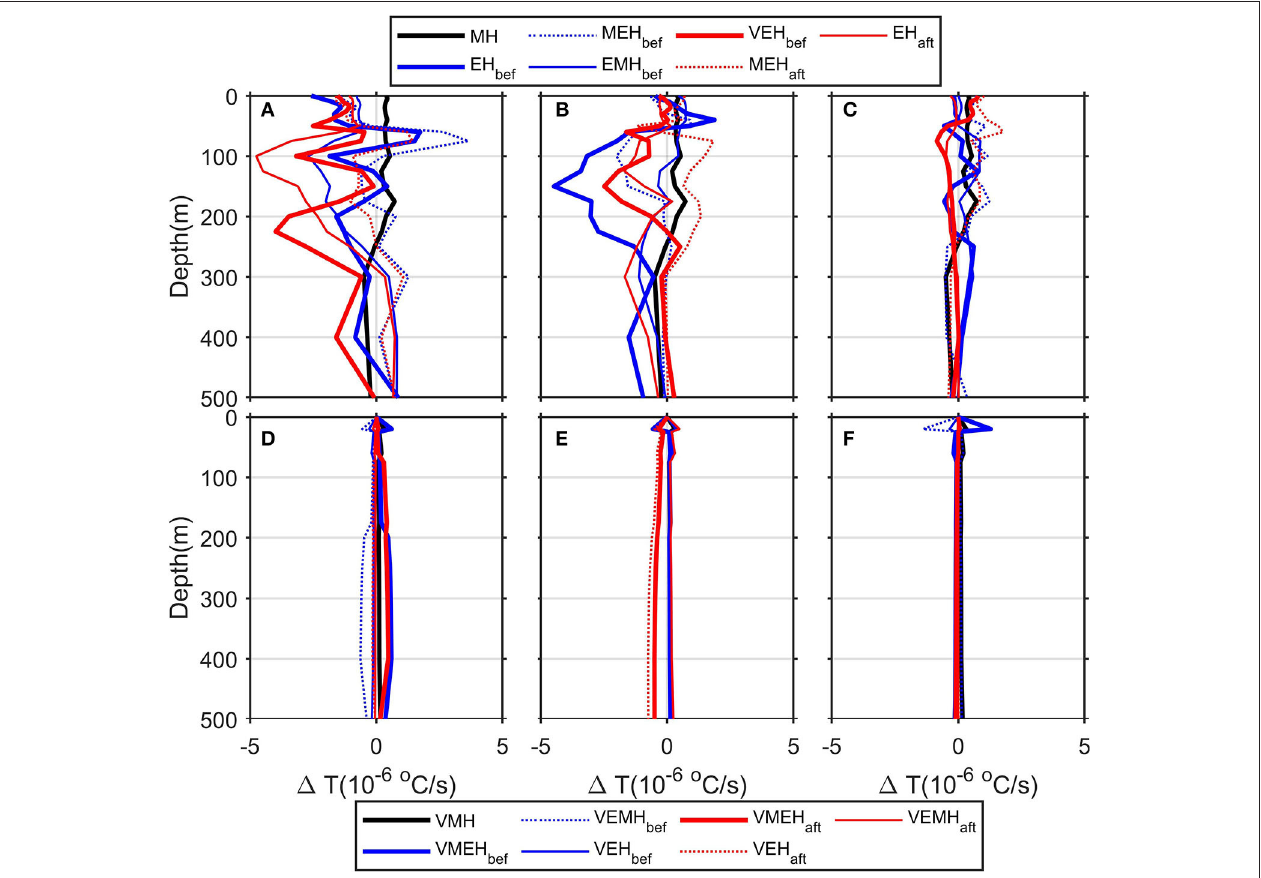
FIGURE 7 | Heat transport during TCs (A) and (D) Bailu, (B) and (E) Lingling, and (C) and (F) Mitag. The black lines are the heat fluxes induced by mean flow. Thick blue and red lines are the eddy-advection-induced SST tendency before the tropical cyclone and after cyclone; dot blue and red lines are the mean-flow-induced eddy heat advection before and after TC; light blue and red lines are the eddy-flow-induced mean heat advection before and after tropical cyclones. TCs, tropical cyclones; SST, sea surface